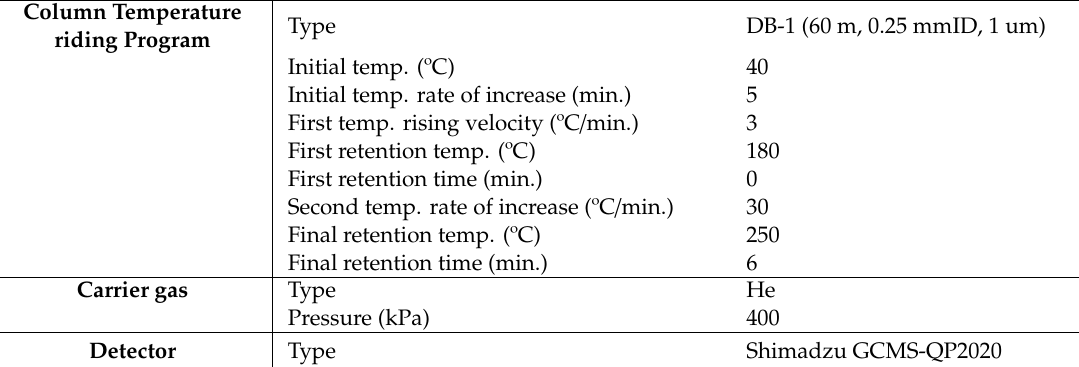
Table A3. Experimental setup of liquid chromatography–mass spectrometry (LC-MS).